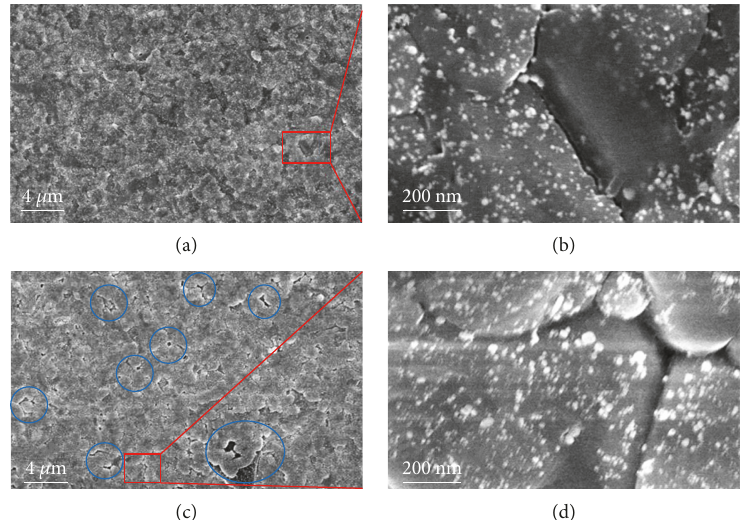
fi lms deposited on the c-TiO NH PbI Cl 3 3 3-X X